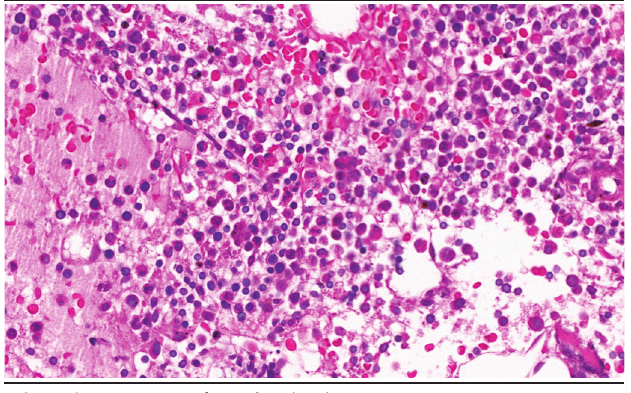
figurE 2 − Bone marrow biopsy (HE, 400×) Malignant neoplasm characterized by small round cell pattern. HE: hematoxilin and